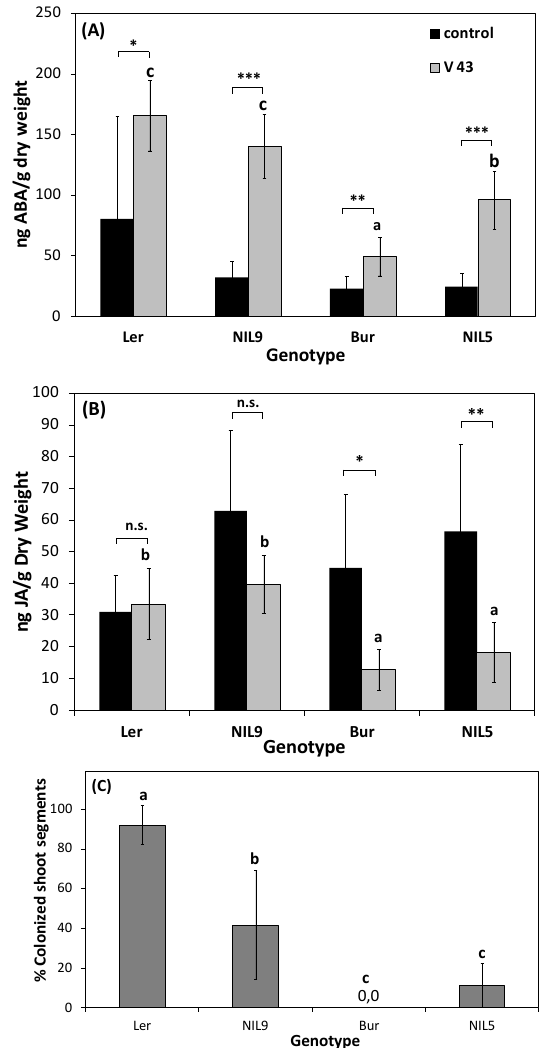
Figure 5. Hormone contents and systemic colonization by V. longisporum in A. thaliana ecotypes L er , Bur, and near-isogenic lines differing in a region containing the colonization resistance QTL vec1 on chromosome 2. Contents of ( A ) abscisic acid (ABA) and ( B ) jasmonic acid (JA) in Bur, L er and two (Bur × L er )-near-isogenic lines (NILs): NIL9 (L er alleles in the variable region) and NIL5 (Bur alleles). Asterisks refer to the significance level of differences between mock-inoculated and V. longisporum -treated plants within one genotype ( t -test). Mean contents of inoculated plants marked with different letters differed significantly at p < 0.05. Mean phytohormone contents of controls did not differ significantly (one-way ANOVA and post-hoc Tukey test). N = 6–7, each replicate corresponded to a batch of 15 plants. Vertical bars denote standard deviations (data from [79]). (C) Systemic colonization by V. longisporum in the same plants that have been used for phytohormone measurements. Means marked with different letters differed at p < 0.05 (one-way ANOVA and post-hoc Tukey test). N = 6–7, each replicate corresponded to a batch of 15 plants. Vertical bars denote standard